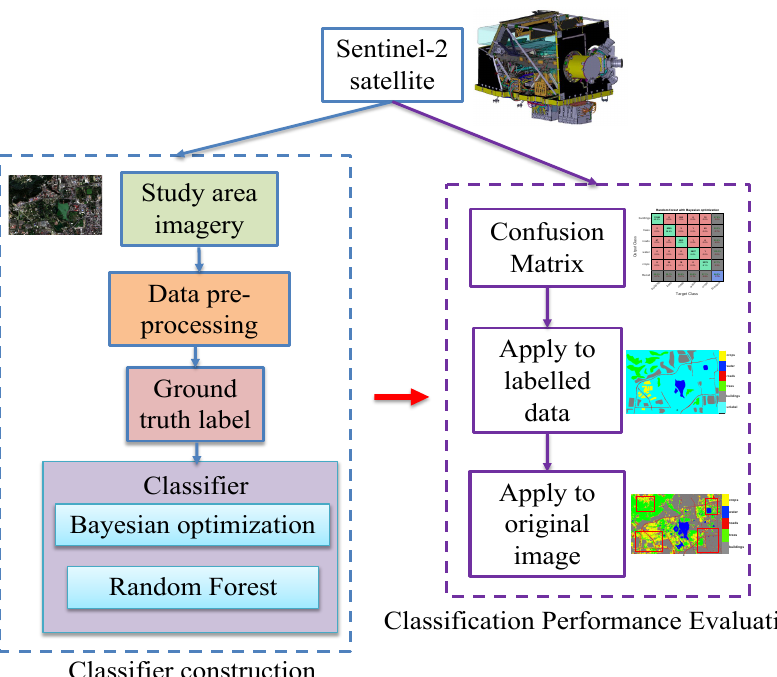
Figure 2. The developed framework for land cover classification by using Sentinel-2 satellite and machine learning based